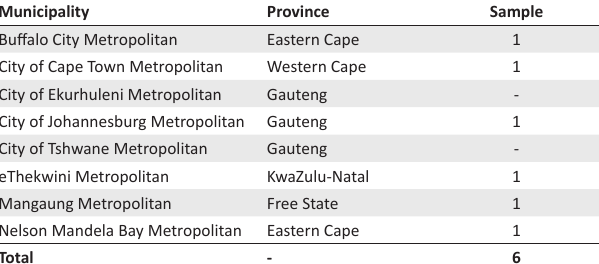
TABLE 5: Sample from the list of metropolitan municipalities.